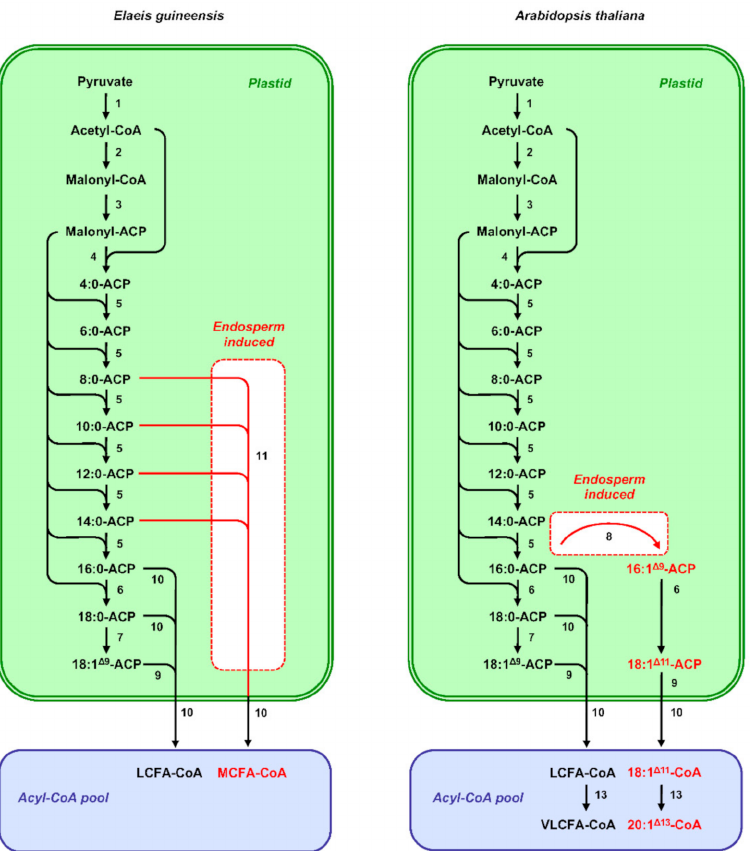
Figure 1. Overview of fatty acid metabolism in maturing seeds of Elaeis guineensis and Arabidopsis thaliana . The scheme depicts the different pathways involved in the synthesis and elongation of fatty acids in maturing seeds. Enzymatic steps transcriptionally induced in the endosperm with respect to the embryo are denoted in red and highlighted in white boxes. 1, pyruvate dehydrogenase; 2, acetyl-coenzyme A carboxylase; 3, malonyl-coenzyme A:acyl carrier protein S-malonyltransferase; 4, fatty acid synthase complex comprising 3-ketoacyl-ACP synthase III; 5, fatty acid synthase complex comprising 3-ketoacyl-ACP synthase I; 6, fatty acid synthase complex comprising 3-ketoacyl-ACP synthase II; 7, ∆ 9 stearoyl-acyl carrier protein desaturase; 8, ∆ 9 palmitoyl-acyl carrier protein de- saturase; 9, FatA fatty acyl-ACP thioesterase; 10, FatB fatty acyl-ACP thioesterase; 11, Specialized FatB fatty acyl-ACP thioesterase releasing medium-chain fatty acids; 12, long-chain acyl-coenzyme A synthetase; 13, fatty acid elongase complex. Abbreviations: ACP, acyl carrier protein; CoA, coenzyme A; LCFA, long-chain fatty acid; VLCFA, very-long-chain fatty acid. After export from the plastid, activation to CoA esters, and transport to the endo-